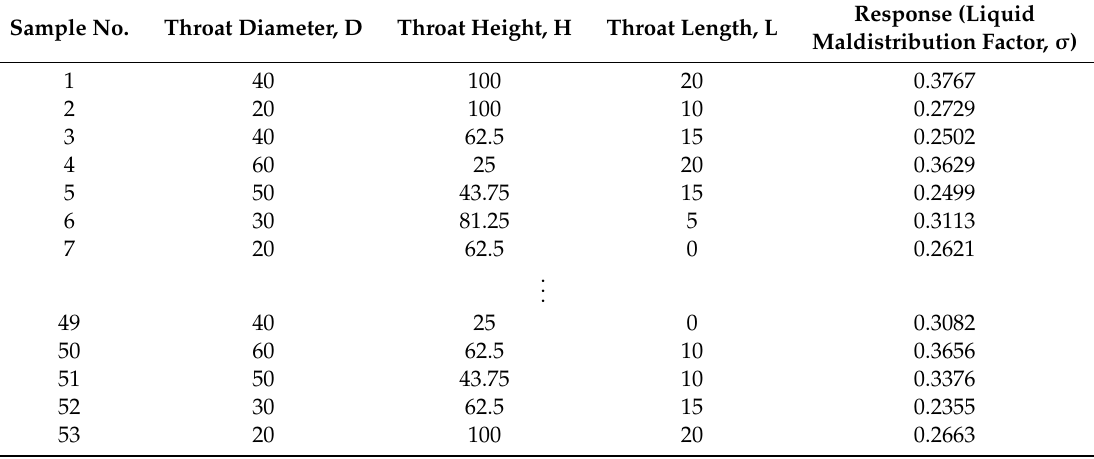
Table 3. Experimental plan designed by response surface methodology (RSM) and corresponding responses. Sample